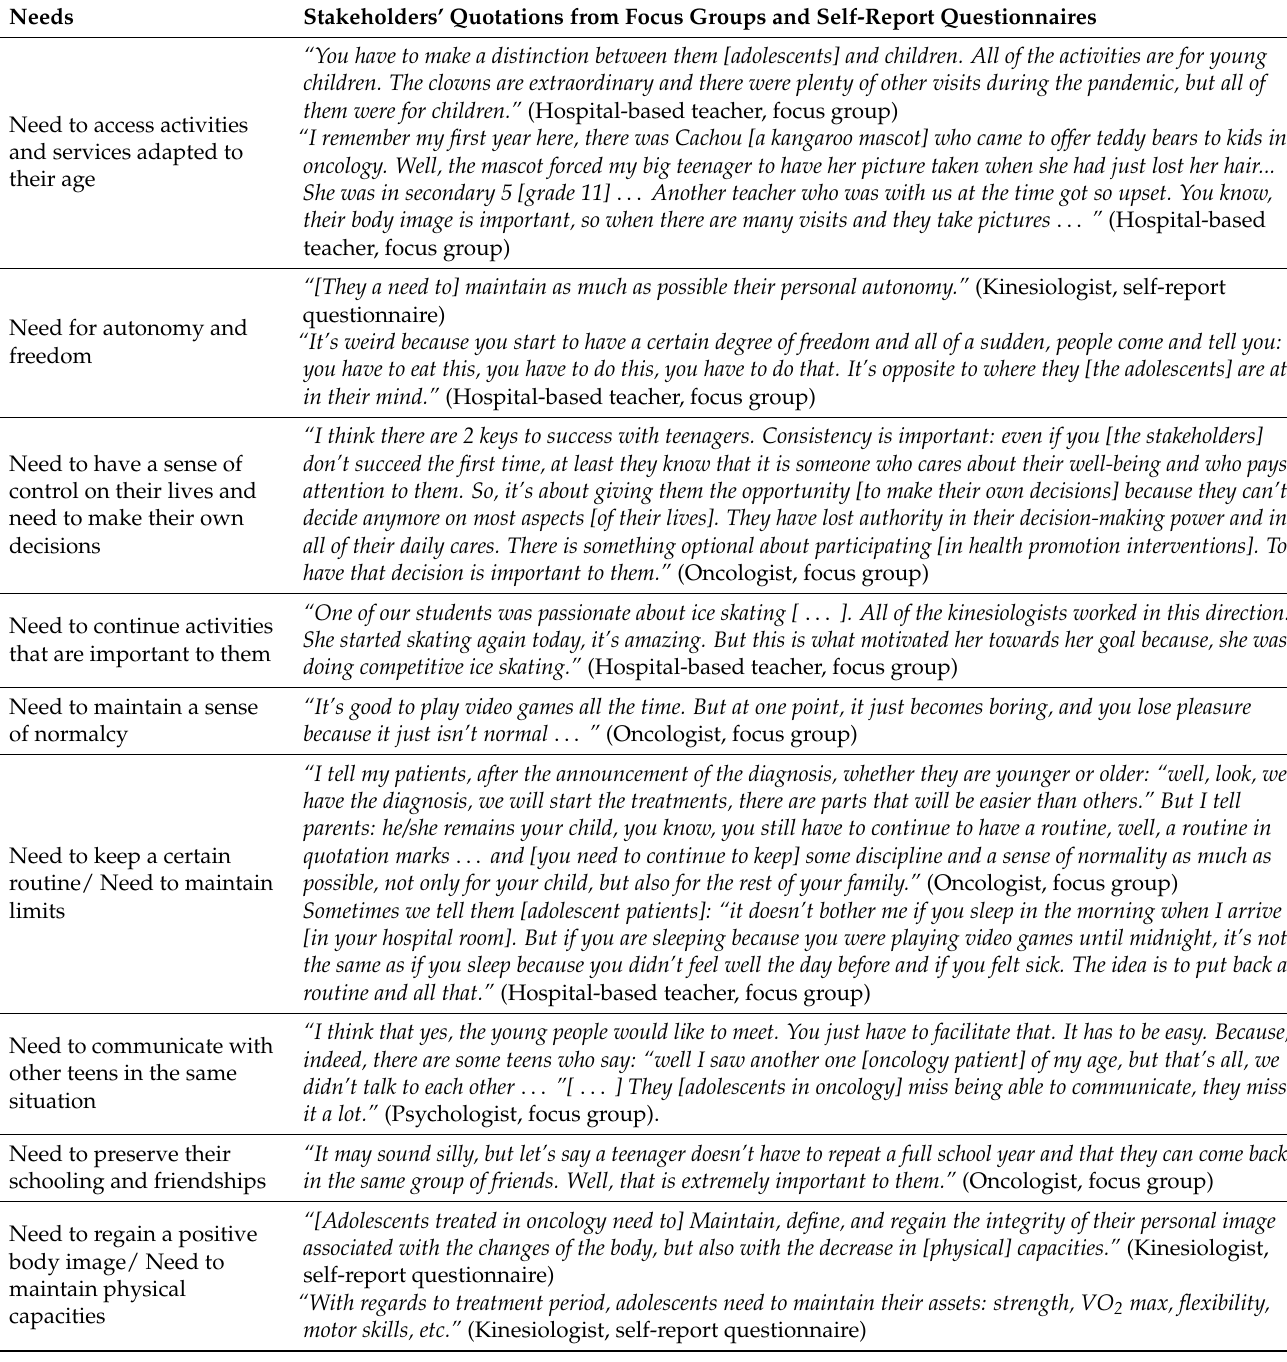
Table 2. Stakeholders’ perception of the specific needs of adolescents in